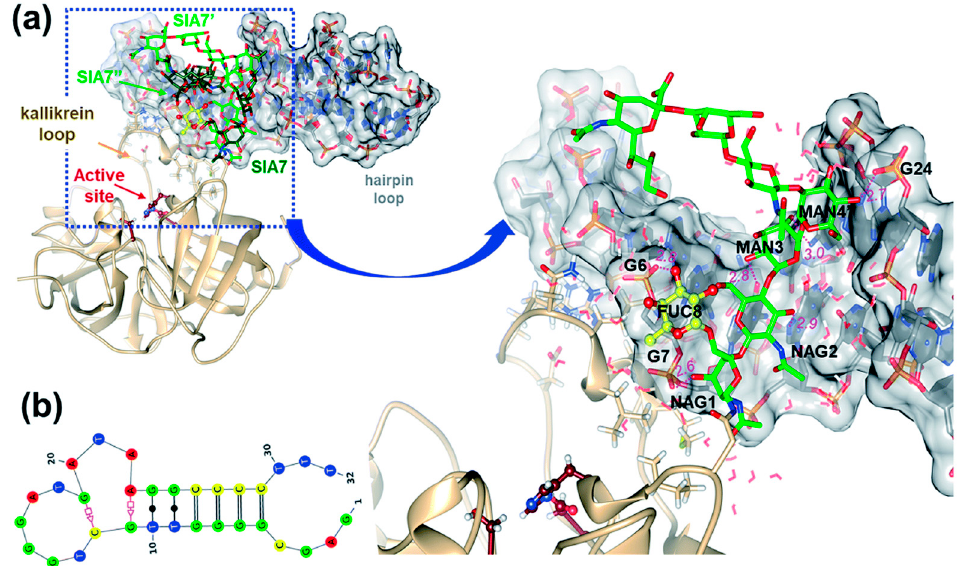
Figure 18. Graphical representation of binding between DNA aptamer recognising glycan part on PSA glycoprotein. hPSA/T-PSAG-1 MD simulation ( a ) Ribbon and stick representations of the hPSA glycoprotein in complex with T-PSAG-1. The structure shown corresponds to a cluster representative from the hPSA/T-PSAG-1 MD trajectory. The sugar residues and specific protein residues (numbered as in the 3QUM crystal structure) are shown in stick models. The T-PSAG-1 aptamer is shown in stick representation with filled nucleobases and enclosed by its transparent molecular surface. For the sake of clarity, the coordinates of the α 1,6– β 1,2 and α 1,6– β 1,6 sugar antennas are removed in the enlarged view. MD-averaged interatomic distances between heavy atoms for selected contacts are indicated in Å. ( b ) Secondary structure of the complexed T-PSAG-1 aptamer obtained from the same cluster representative. Reprinted from ref. [199] under a Creative Commons Attribution